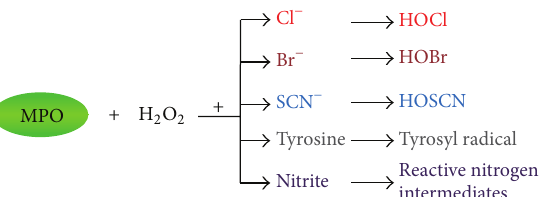
Figure 1: Reactive intermediates formed by MPO . In the presence of hydrogen peroxide and chloride, bromide, thiocyanate, tyrosine, or nitrite, MPO catalyses the formation of hypochlorous, hypobromous, and hypothiocyanous acids, tyrosyl radical, and reactive nitrogen intermediates. H 2 O 2 , hydrogen peroxide; Cl − , chloride; Br − , bromide; SCN − , thiocyanate; HOCl, hypochlorous acid; HOBr, hypobromous acid; HOSCN, hypothiocyanous